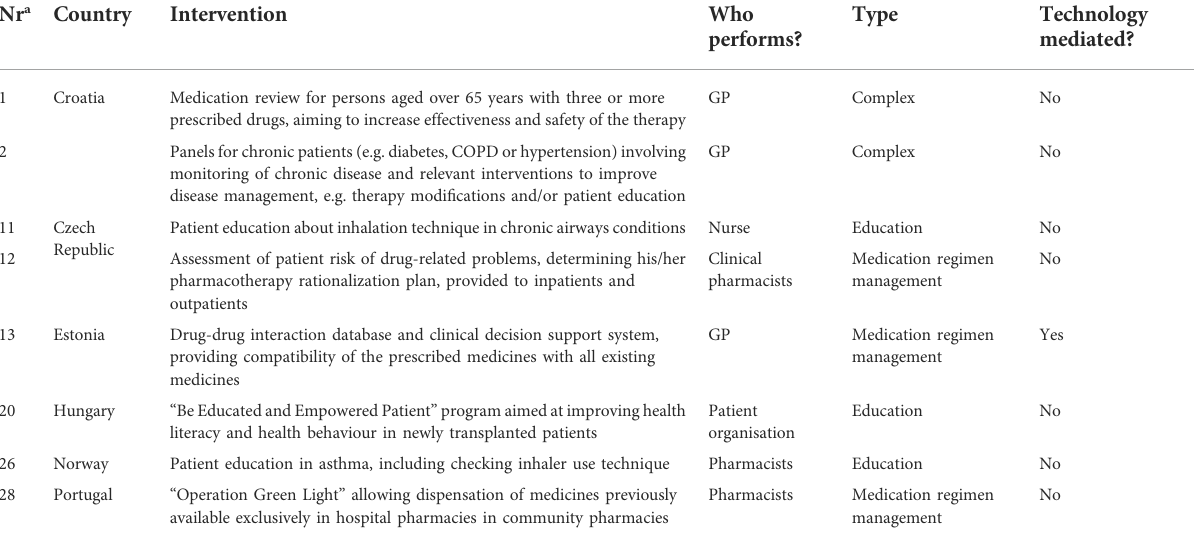
Type Technology performs?